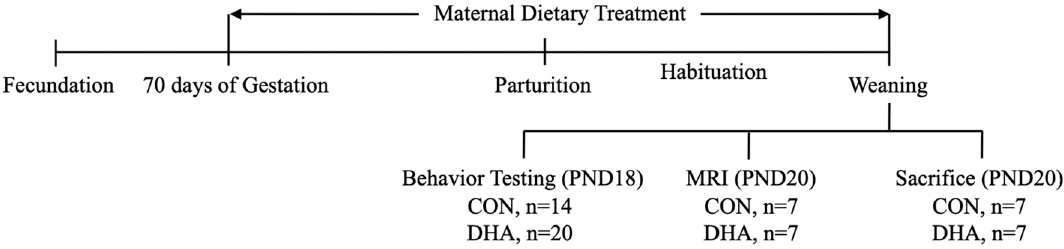
Figure 1. Study design and experimental timeline. CON: control; DHA: docosahexaenoic acid.